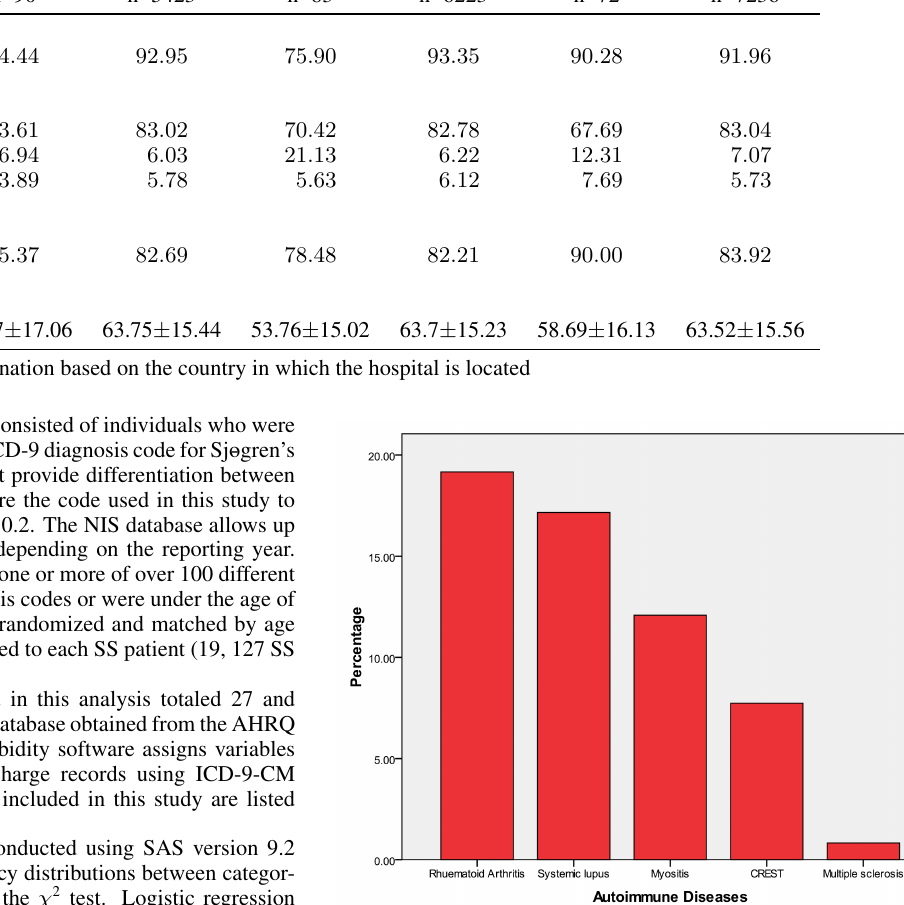
Fig. 1: Distribution of autoimmune diseases coexisting with